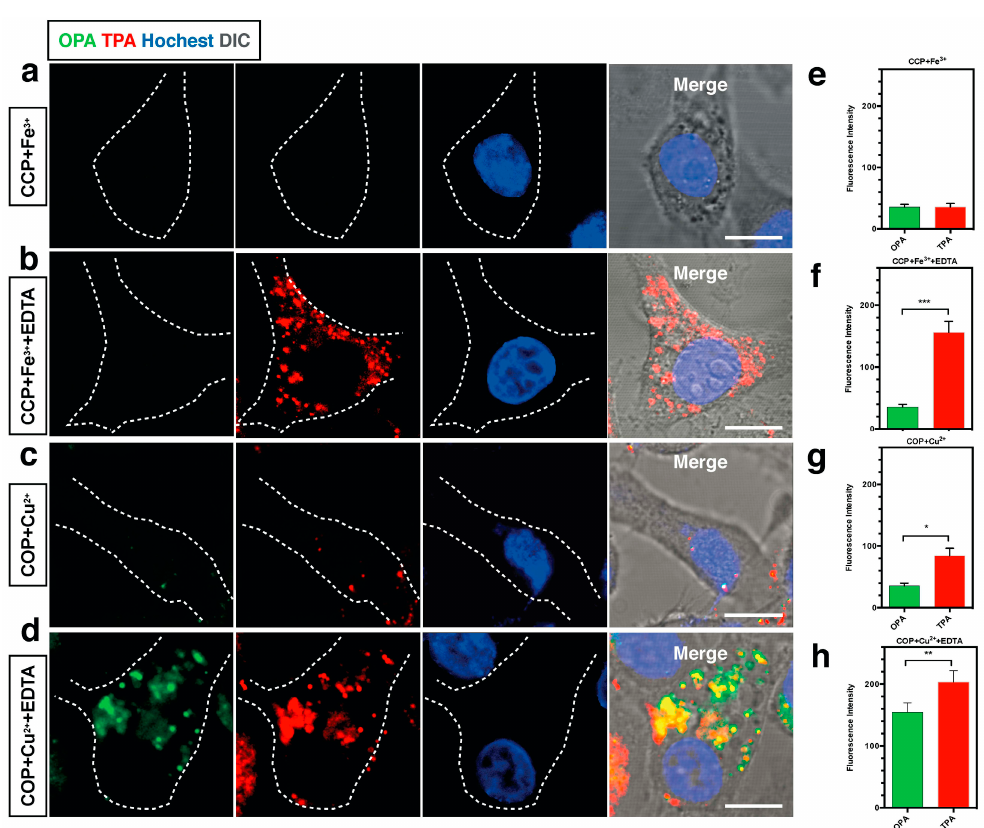
Table 2. Photophysical data of 11 – 21 .